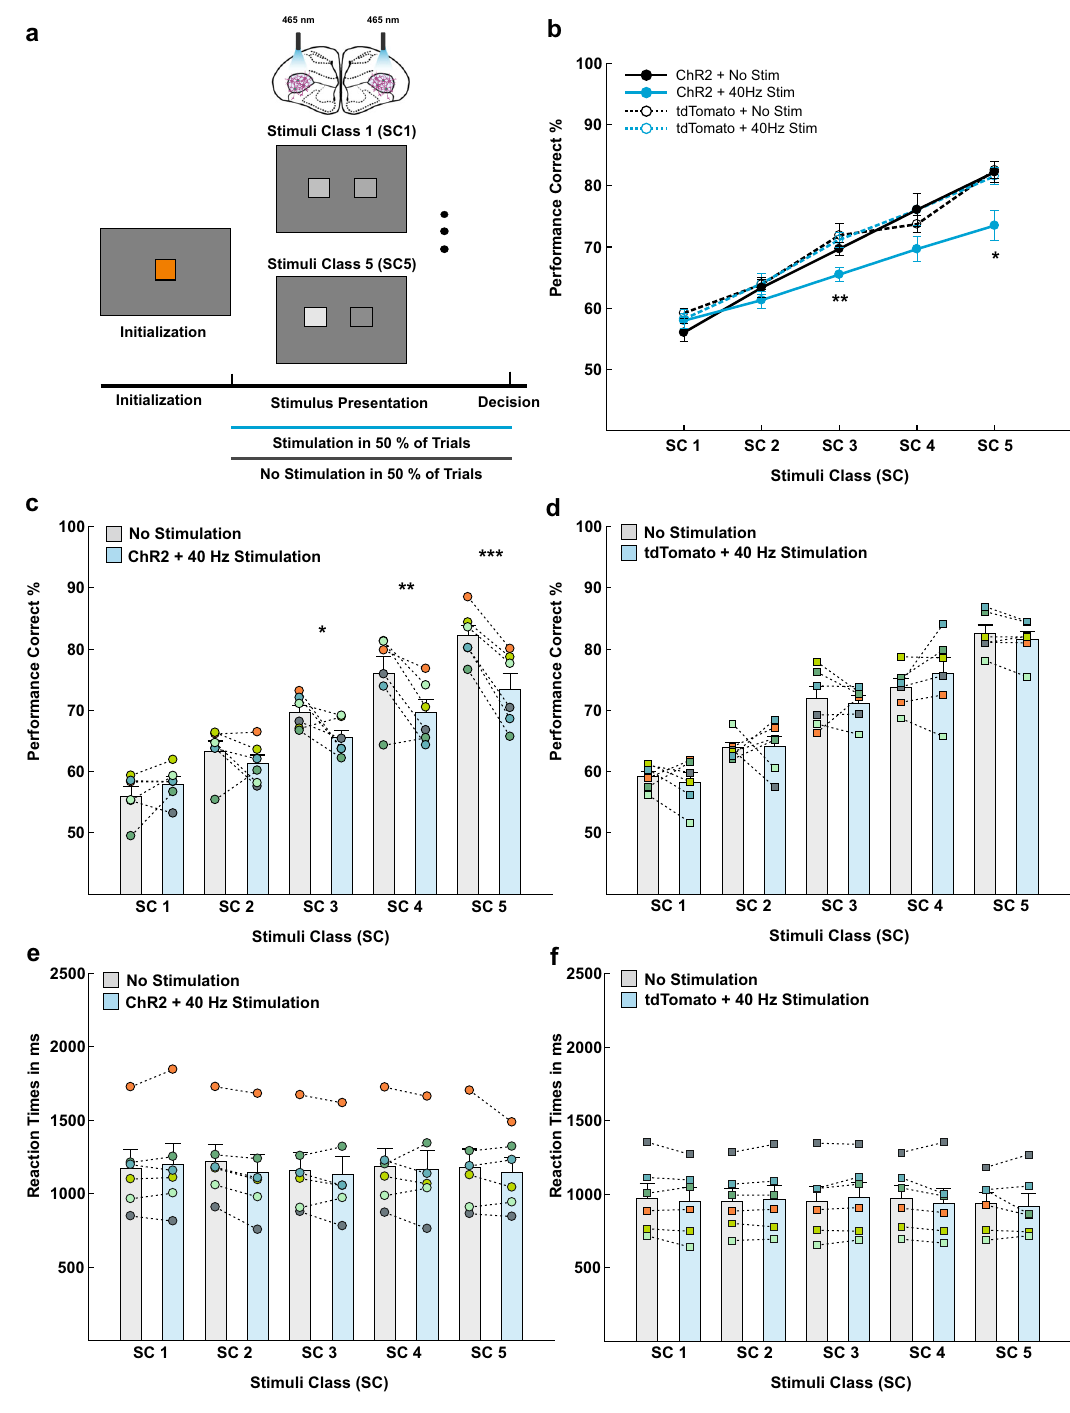
performance in a grayscale visual discrimination task . For all behavioral experiments, AAV1-CAG was used to deliver the ion channel ChR2 or the fl uorescent protein tdTomato into neurons of the entopallium. To investigate the behavioral effect of opto- genetic stimulation, an experimental group expressing ChR2 and a control group expressing tdTomato were bilaterally stimulated in the entopallium during the whole stimulus presentation phase or until the pigeon responded. Stimulation took place in 50% of the trials of a forced-choice visual discrimination task. The remaining 50% of the trials were void of optical stimulation (Fig. 7a).